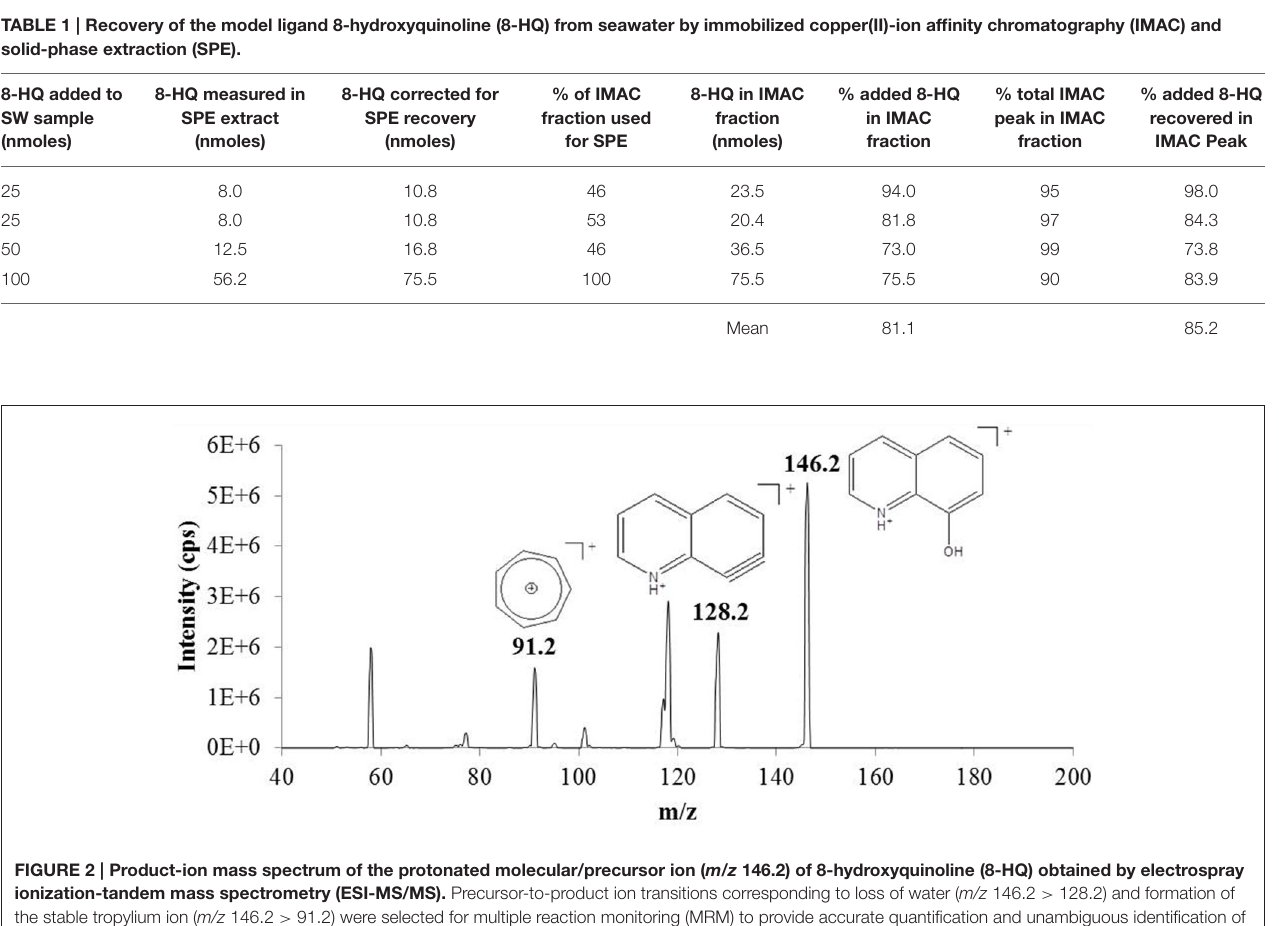
Frontiers in Marine Science |